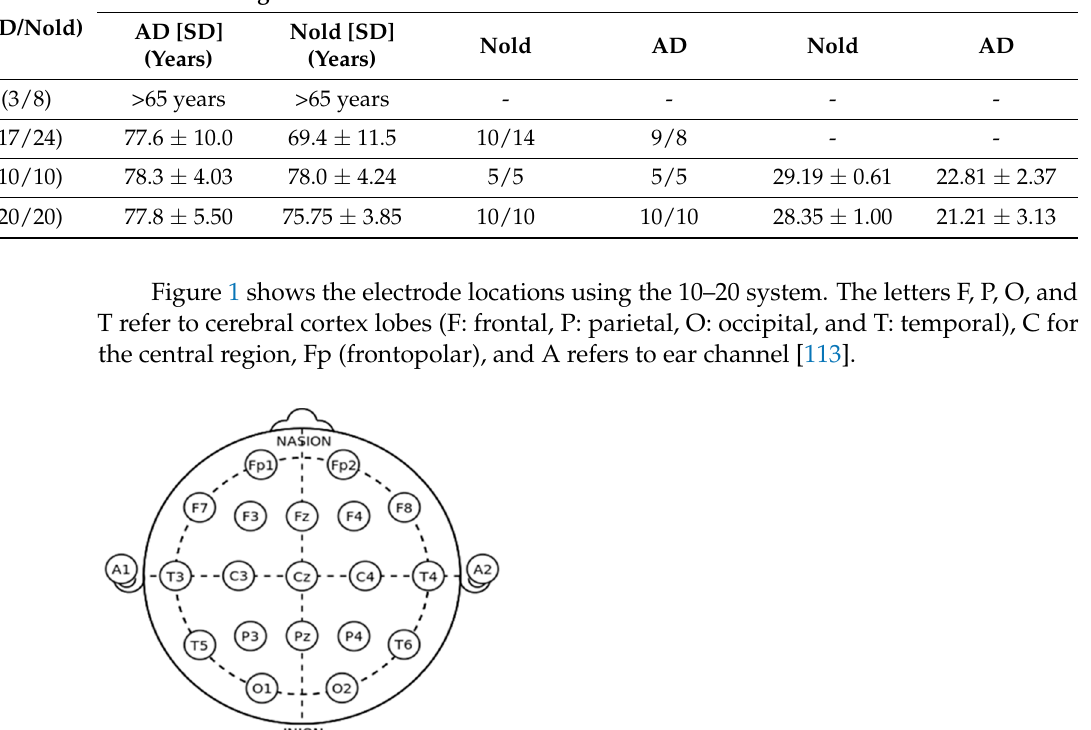
Table 1. Description of the EEG dataset that were used in this study.